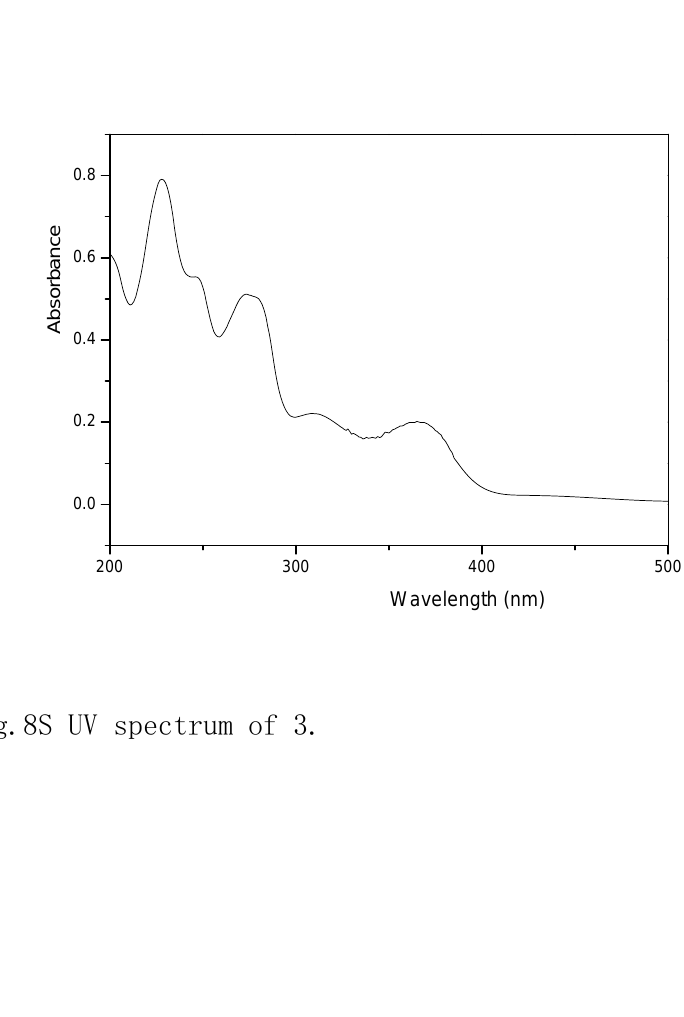
Fig.7S IR spectrum of 3.